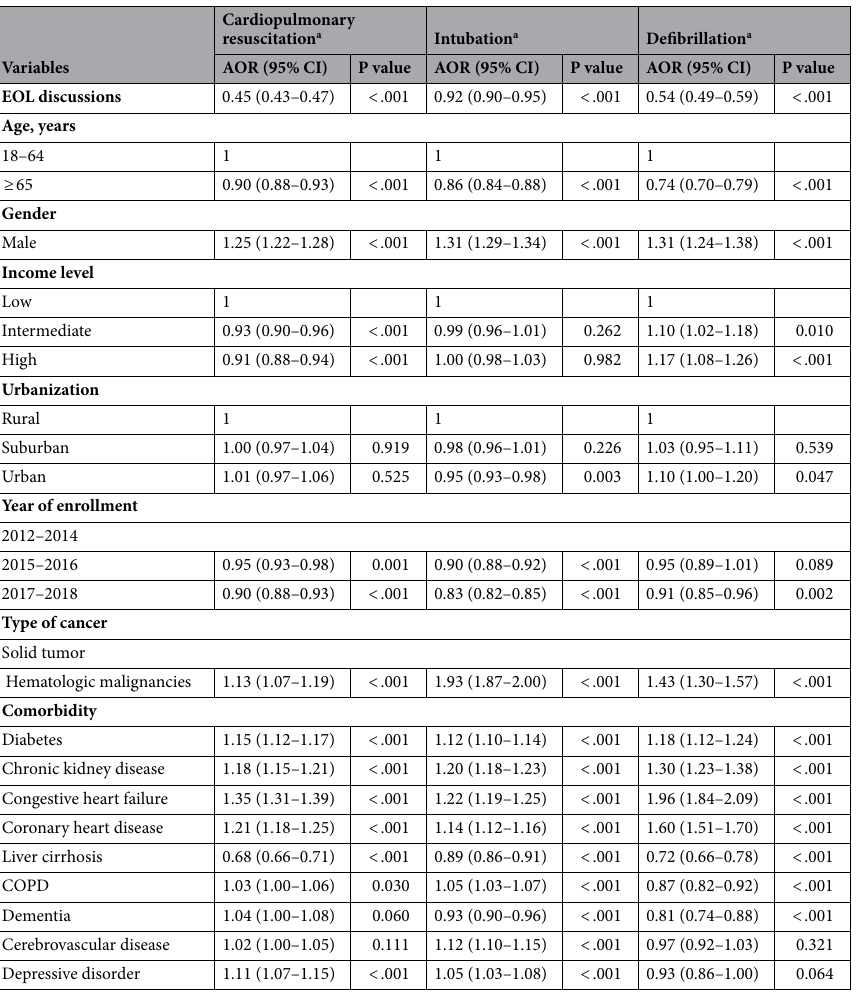
Table 3. Multivariate analysis for the association of end-of-life discussions with cardiopulmonary resuscitation, endotracheal intubation, and defibrillation in deceased cancer patients. AOR, adjusted odds ratio; CI, confident interval; EOL, end-of-life; COPD, chronic obstructive pulmonary disease. a During last 3 months of life.